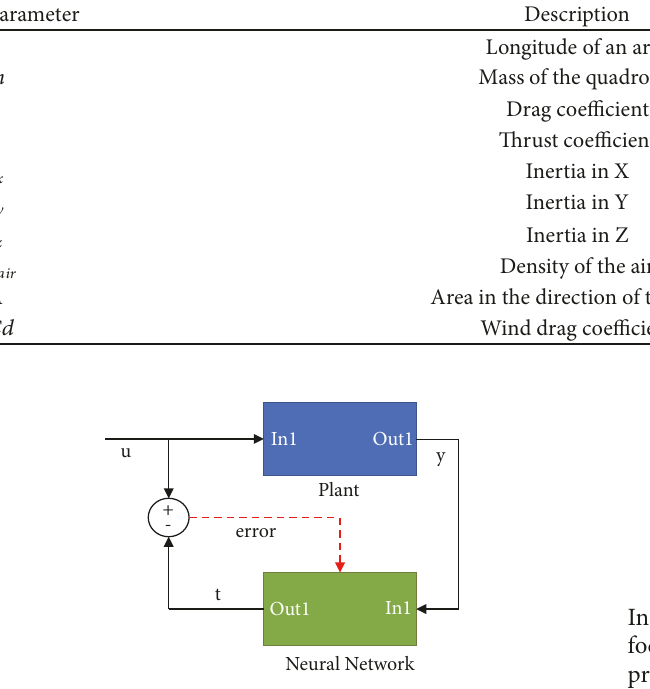
Figure 2: Offline training to identify the plant inverse dynamic.